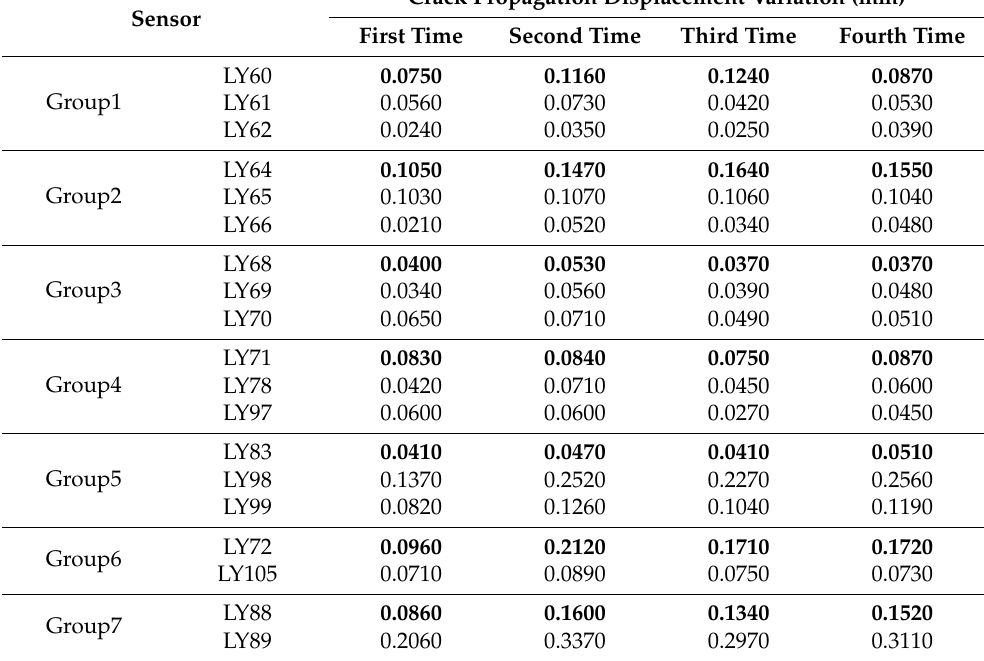
Table 3. Crack propagation displacement variation of the miter gate at the different positions by four times of sampling